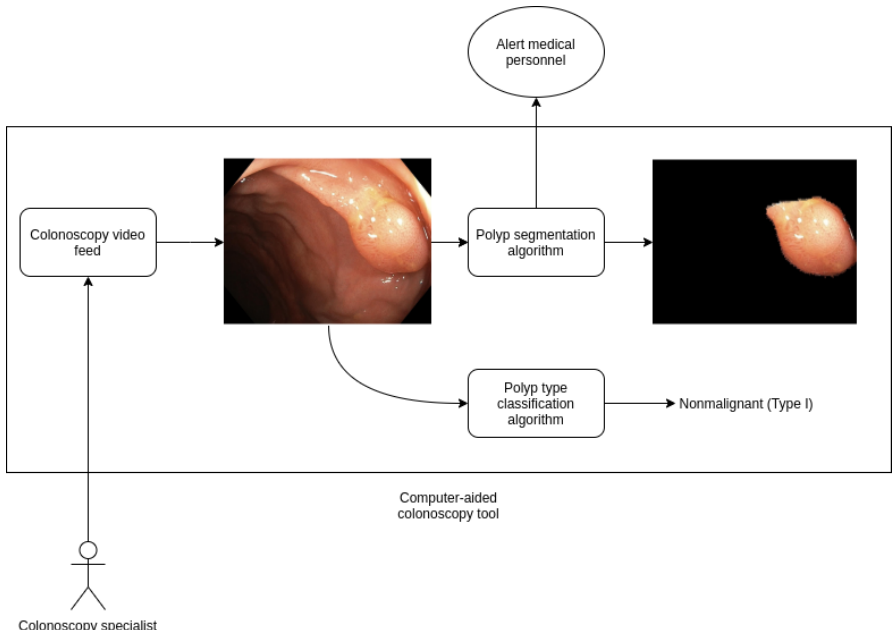
Figure 3. Diagram of a computer-aided diagnosis tool based on our work on polyp detection and